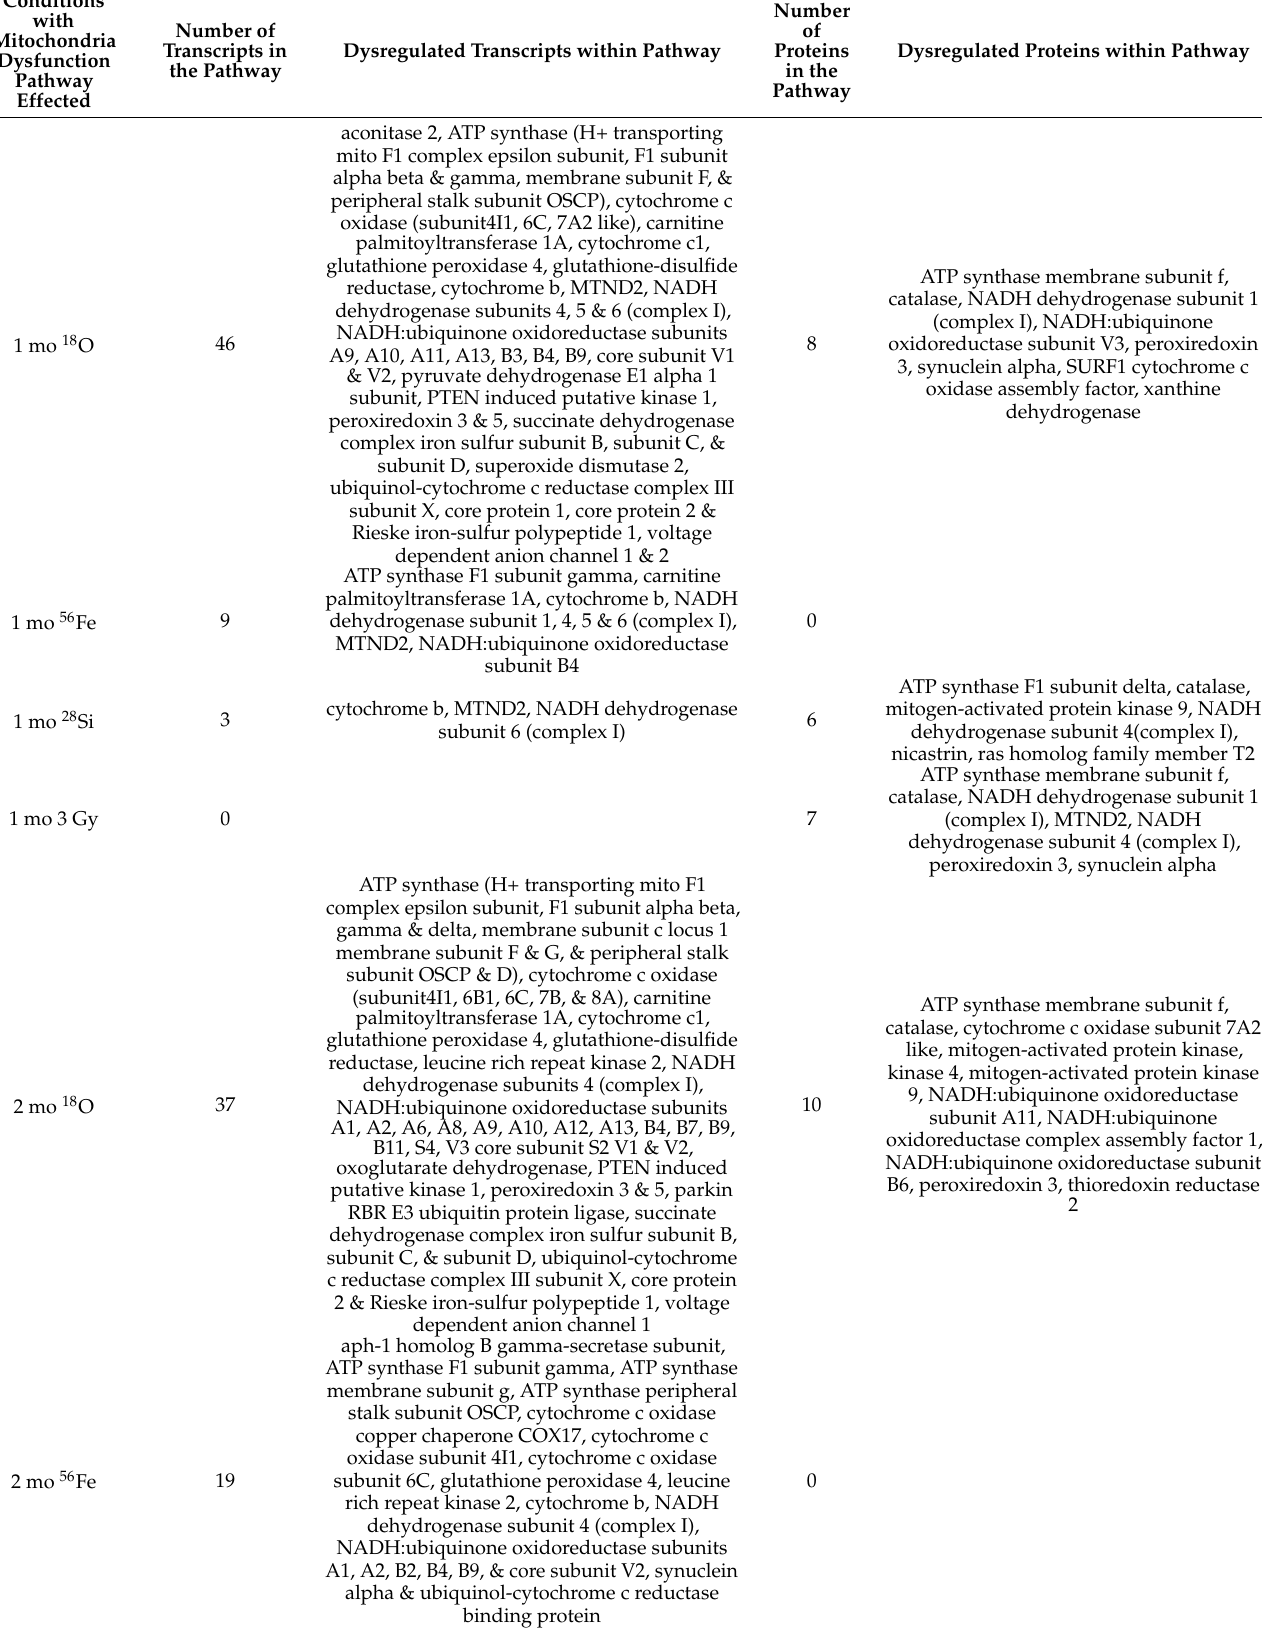
Table 1. Altered Transcripts and Proteins in the Mitochondria Dysfunction